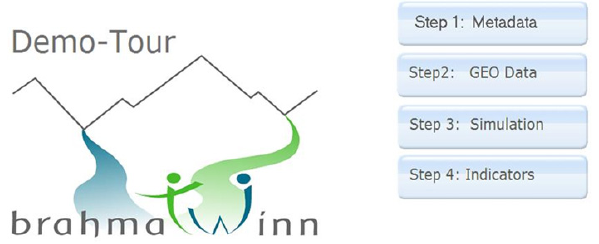
Figure 7. Start GUI for the IWRMS demo-tour of the BRAH- MATWINN